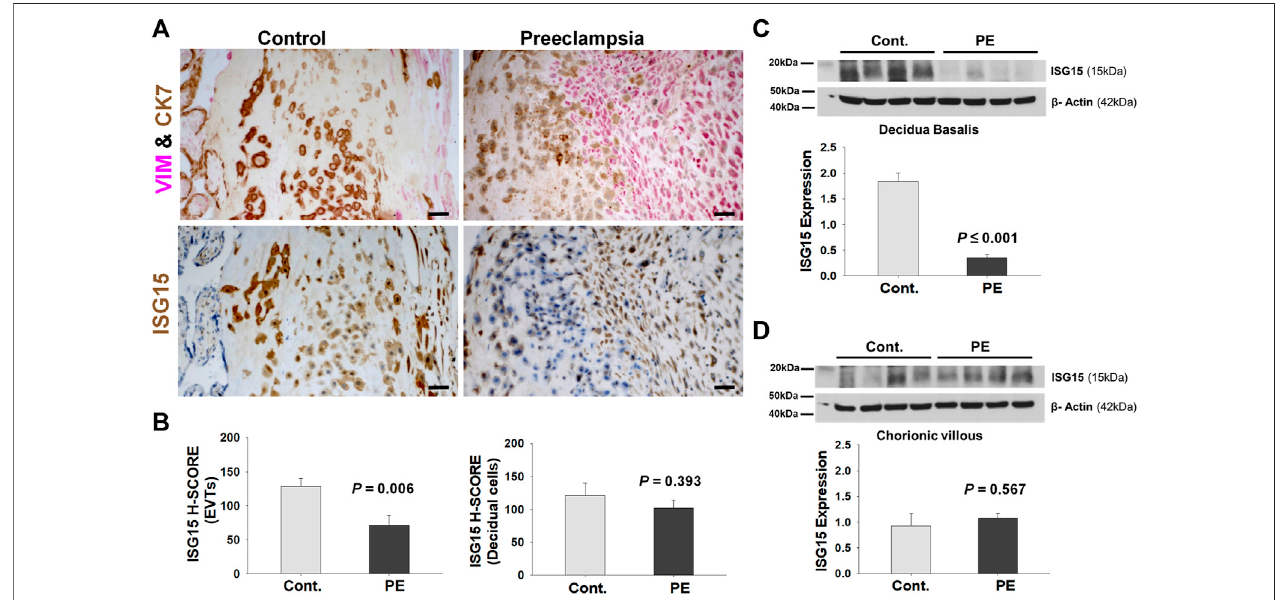
FIGURE 4 | EVTs display diminished ISG15 expression in preeclamptic placenta. (A) ISG15 immunoreactivity in EVTs and decidual cells in vimentin (VIM, red, a decidual cell marker) - cytokeratin7 (CK7, brown, a trophoblast marker) double immuno-stained serial sections of control (Cont, n = 11) vs. preeclamptic (PE, n = 11) placentas. (B) H-SCOREof ISG15 immunoreactivityinEVTsanddecidualcells. (C,D) Westernblotanalysisofdeciduabasalis( C; n =4/group)andchorionicvillisamples ( D ; n = 4/group) showing ISG15 expression in PE vs. control specimens. Bars represent Mean ± SEM and compared by using t -test; Scale bars = 30 µm.